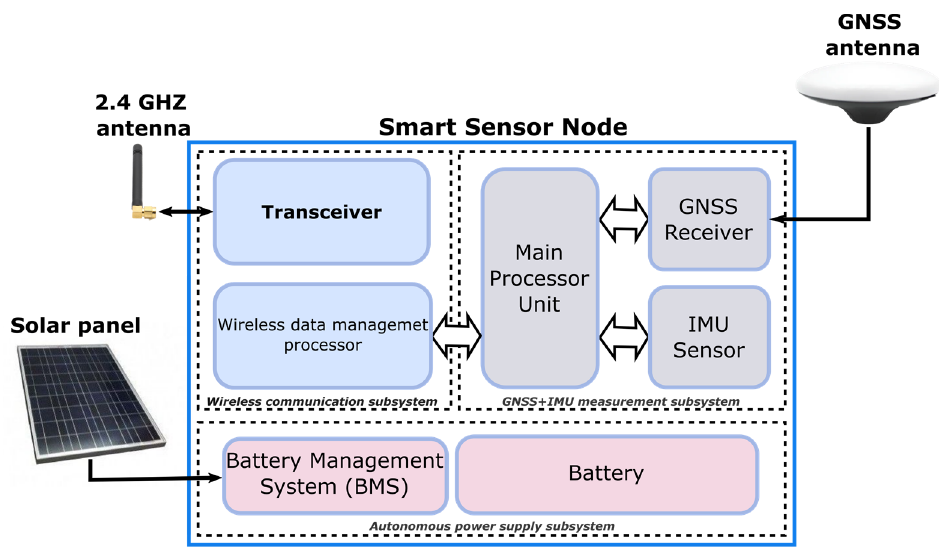
Figure 2. Smart sensor node block diagram.